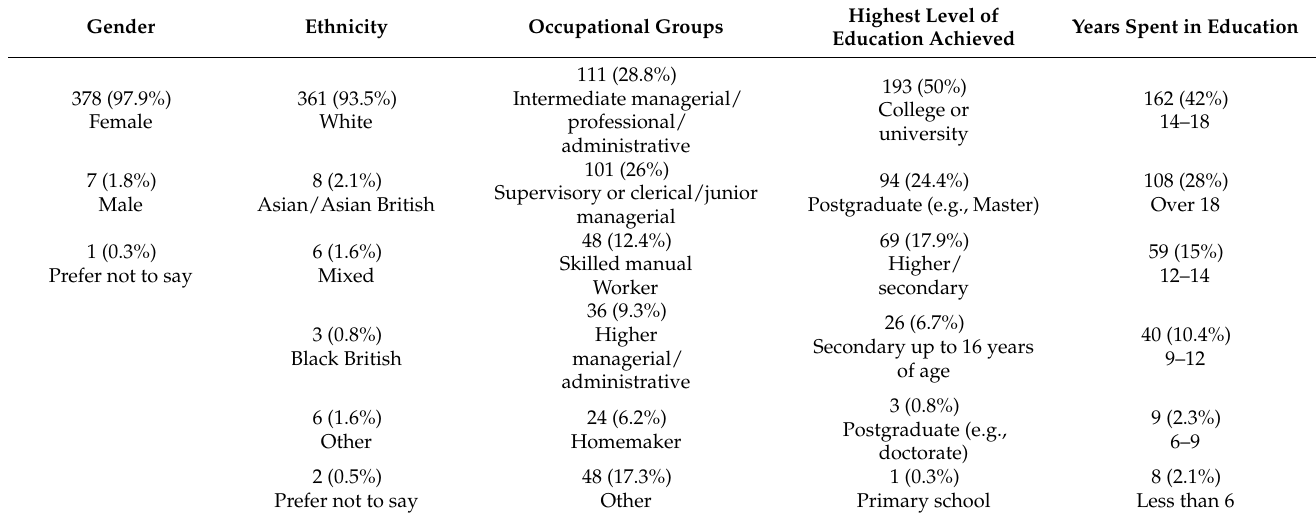
Table 3. Respondents’ demographic characteristics in order of prominence in the